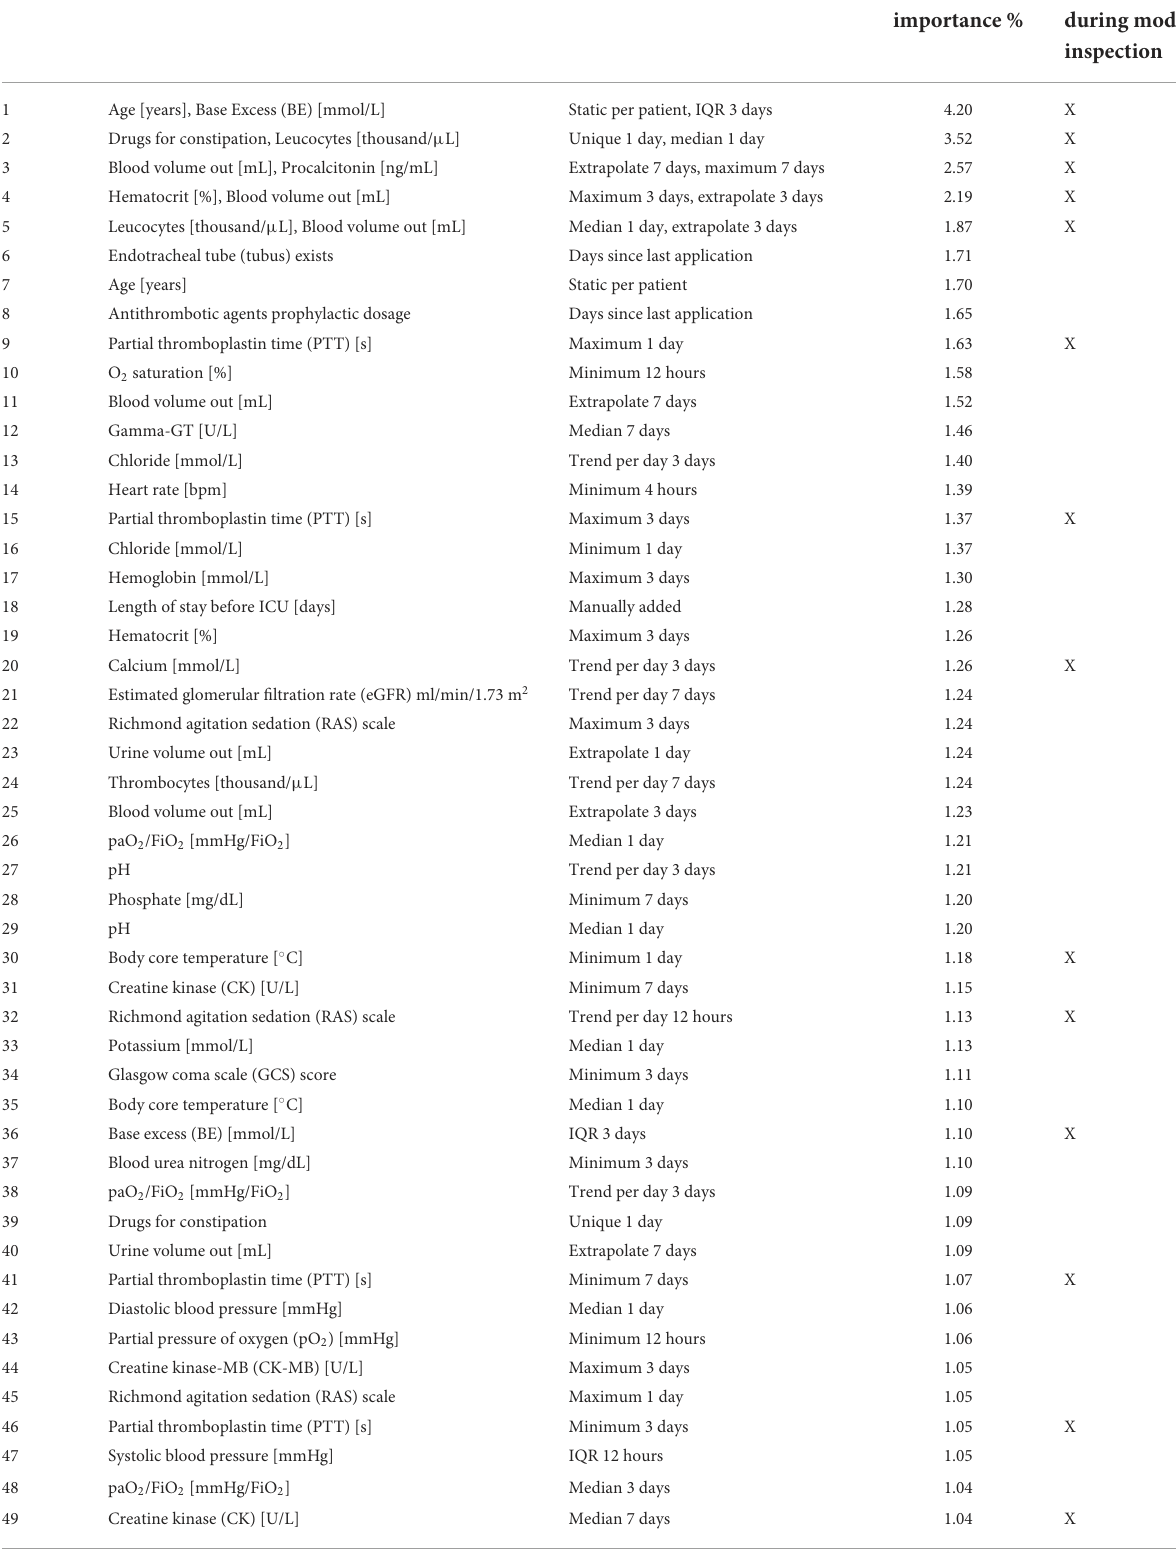
TABLE 2 Overview of the variables and features of the risk functions included in the final EBM model ordered by